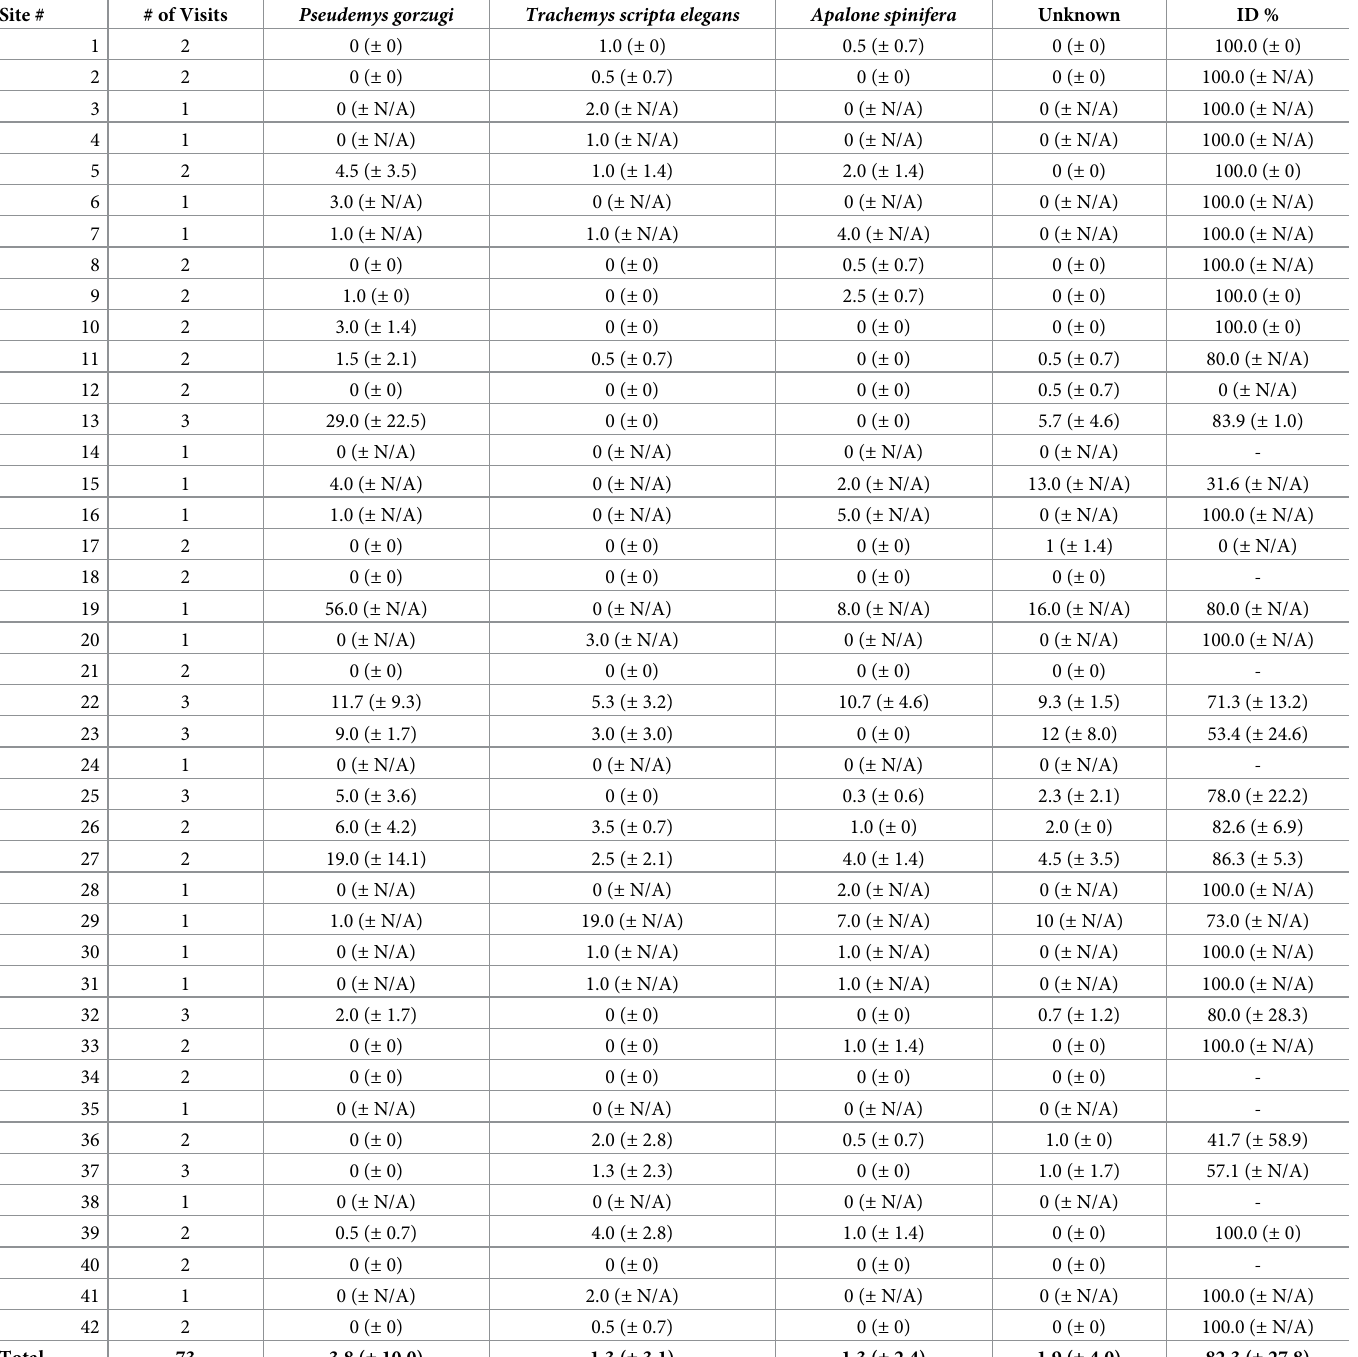
Table 1. Turtle detections and identification percentages from drone